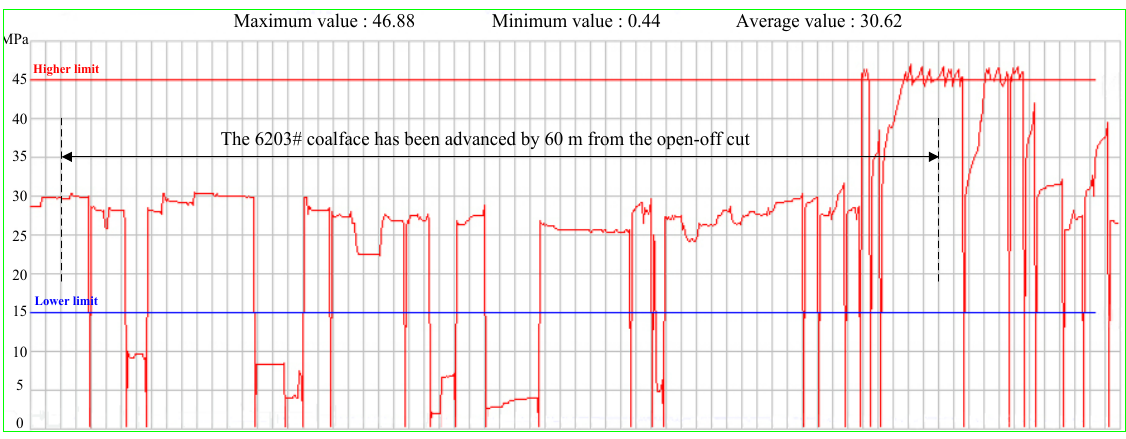
Figure 17. The relationships of through cracks, radon data and working